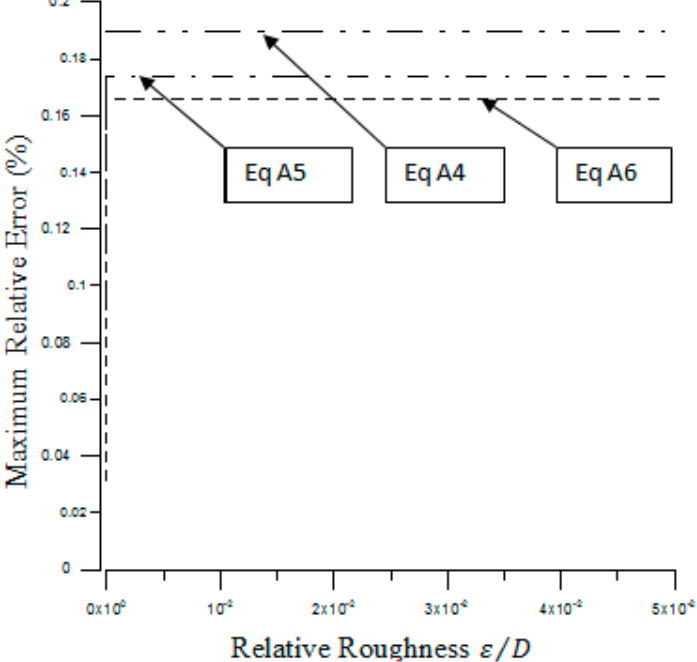
Figure 2. The maximum deviation (in percent) for versus different relative roughness. Values of Equations: 2, 3 and 4 (A1–A3) using B of Equation (A7).